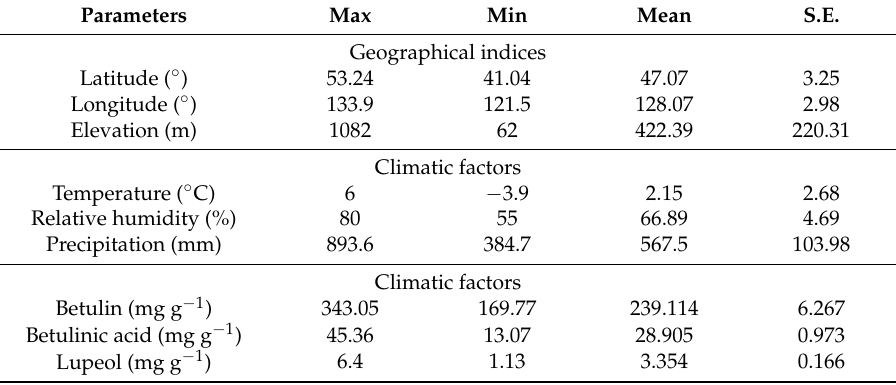
Table 2. Descriptive analysis of geographical indices, climatic factors and triterpenoid concentrations in birch tree bark and geographical and climatic indices for 48 sampling plots in Northeast China.